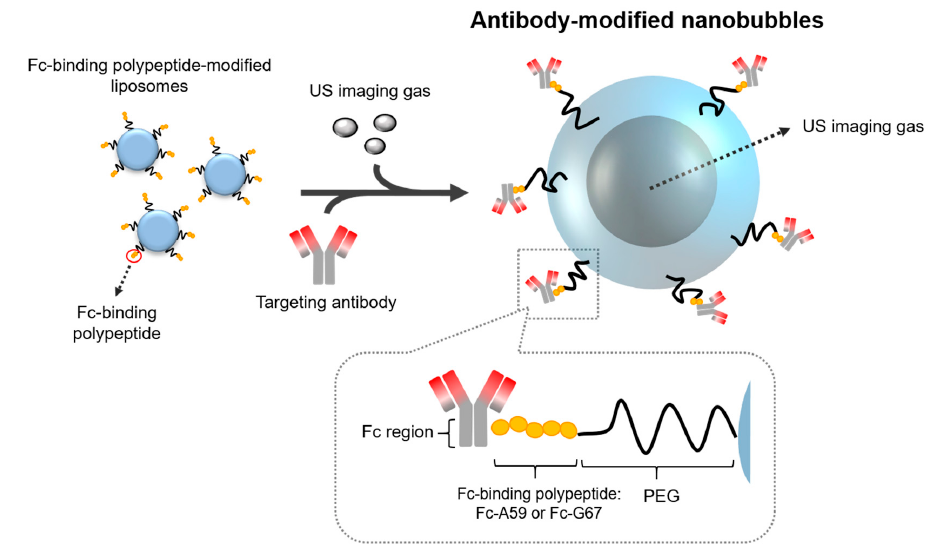
Figure 1. Schematic of the development of antibody-modified nanobubbles (NBs) using an Fc-binding polypeptide. PEG—polyethylene glycol; US—ultrasound.